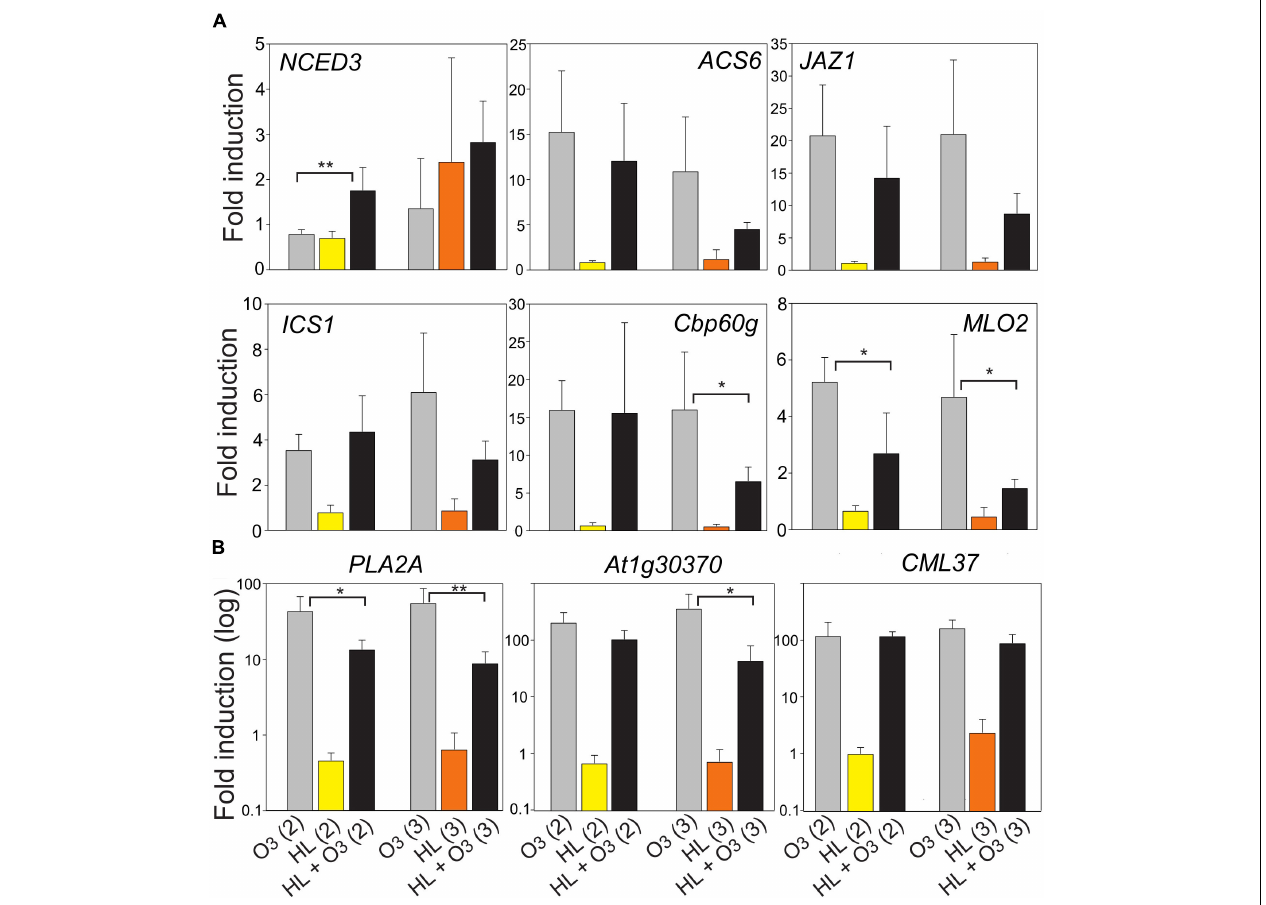
FIGURE 8 | Fold induction of selected marker genes after 1 h HL, 1 h O 3 (350 nL L - 1 ) or combined treatment (growth conditions Helsinki-2 and Helsinki-3, Table 1 ). Panel (A) has normal scale and panel (B) log10 scale, to better visualize the large differences in transcript levels between samples. The average of four biological replicates are shown; error bars depict standard deviation. The t -test was used for statistical analysis and depicts significant differences between O 3 and combined O 3 + HL (* P < 0.05; ** P <